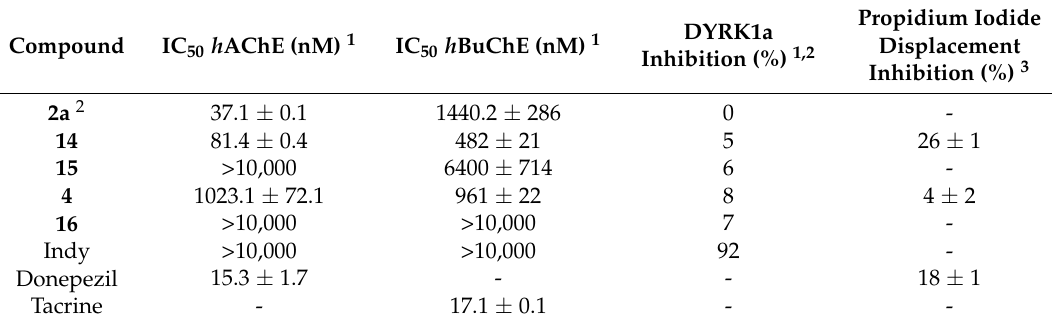
Table 1. In vitro evaluation of compounds 4 , 14 – 16